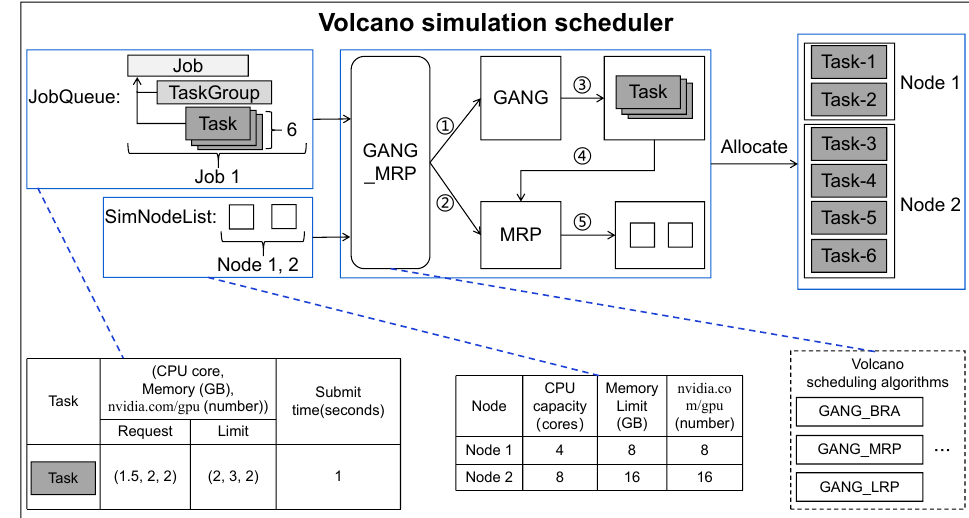
Figure 6. An example of JobQueue scheduling using GANG_MRP in Volcano simulation